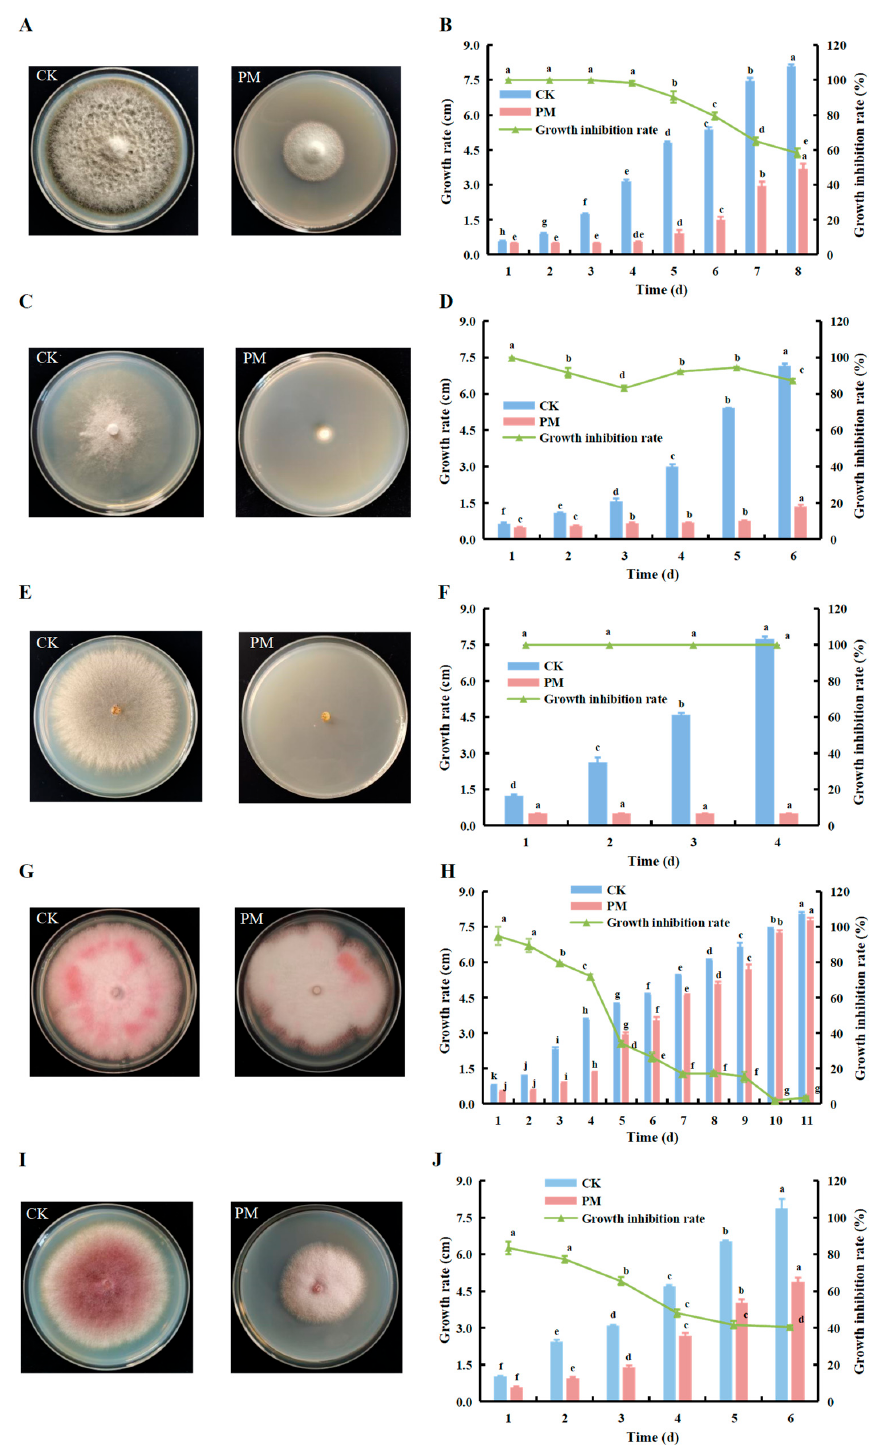
Figure 4. Inhibition of the soil-borne pathogenic fungi by the pink pigment. The inhibition rates of the pink pigment on Alternaria solani ( A , B ), Sclerotinia sclerotiorum ( C , D ), Rhizoctonia solani ( E , F ), Fusarium oxysporum . f. sp cucumerinum ( G , H ), and Fusarium proliferatum ( I , J ) were determined. CK is the control group without pink pigment; PM is the treatment group with pink pigment. Different letters indicate significant differences in the pink pigment under different treatments at p < 0.05, and error bars were expressed in the form of ±standard error (SE).